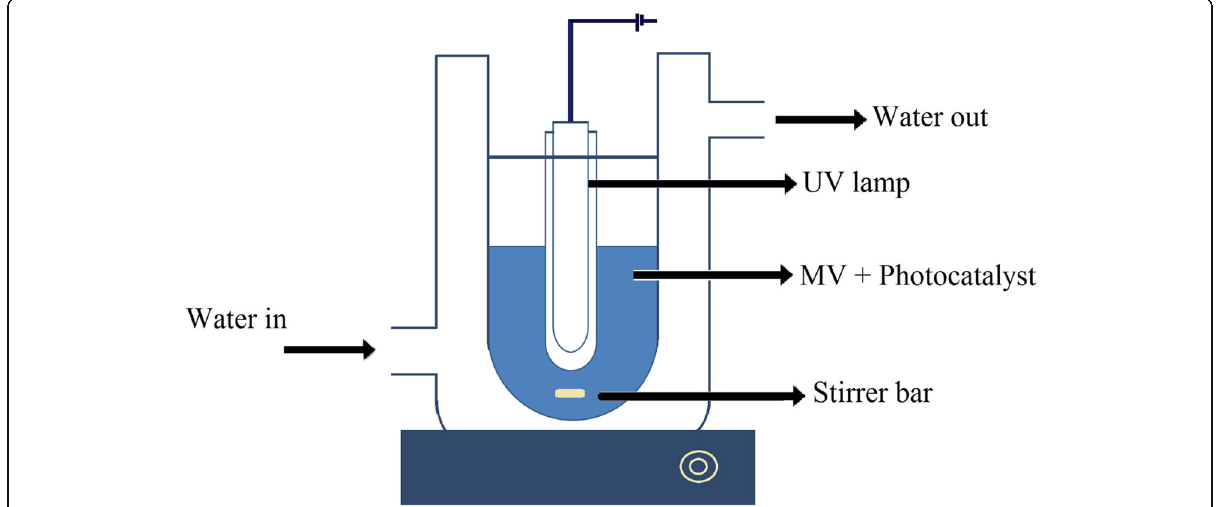
Fig. 1 Schematic representation of photocatalytic